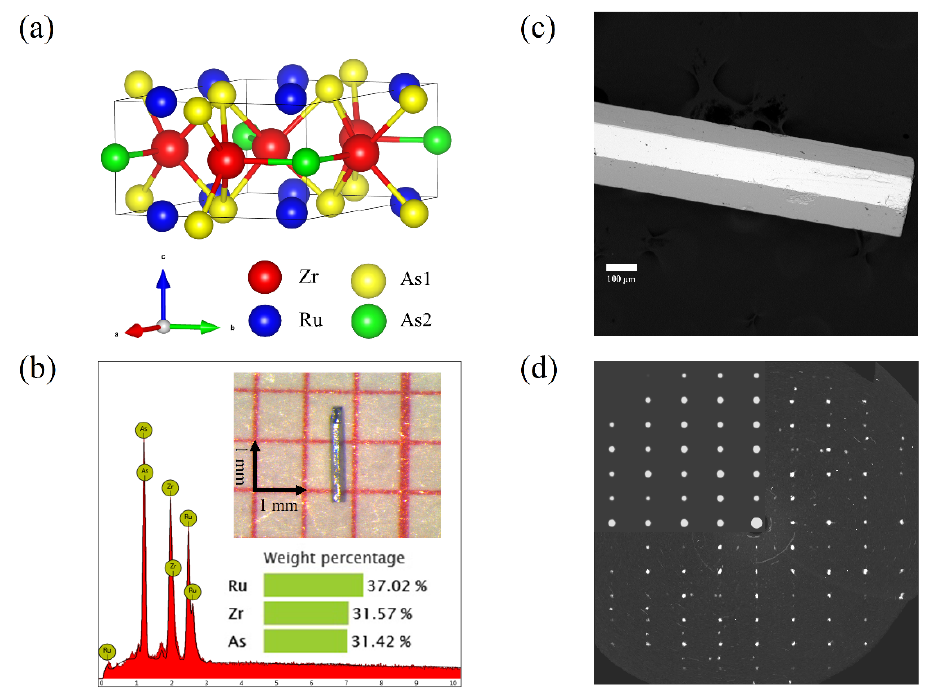
Figure 1. ( a ) Crystal structure of TT ’ X (take ZrRuAs as an example). T and T ’ are represented by red and blue spheres, respectively, and the two types of X environment are indicated by the yellow and green spheres. The unit cell is shown by the parallelepiped. ( b ) EDS and optical photograph of ZrRuAs. ( c ) SEM images of ZrRuAs. ( d ) Single crystal diffraction pattern of Fe 2 P ‐ type structure on (010) plane.